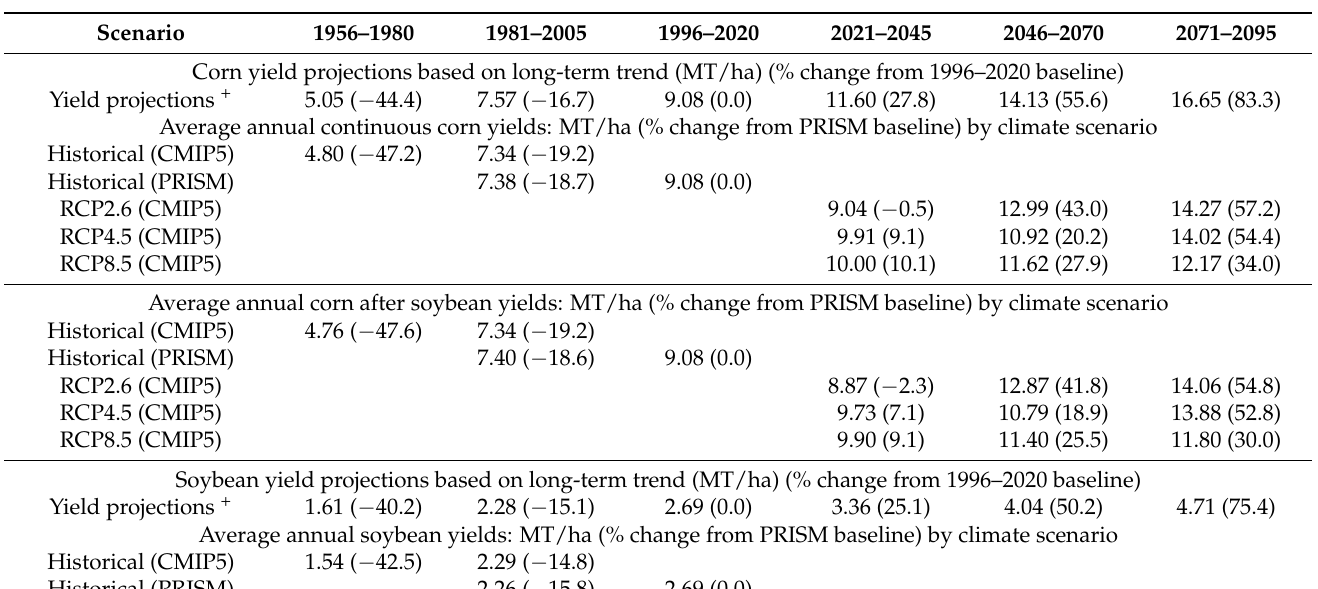
Table 10. Simulated corn and soybean yields by climate scenario based on 2019–2021 management and crop genetics and long-term yield trends